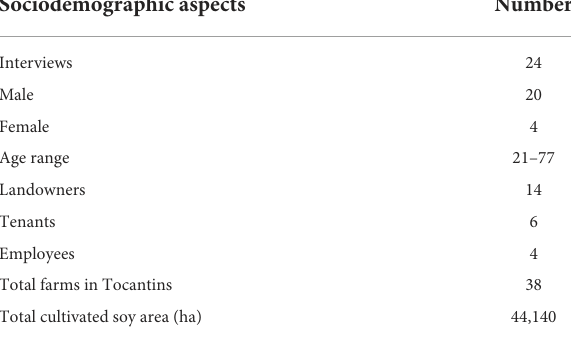
TABLE 3 Sociodemographic profile of the 24 farmers